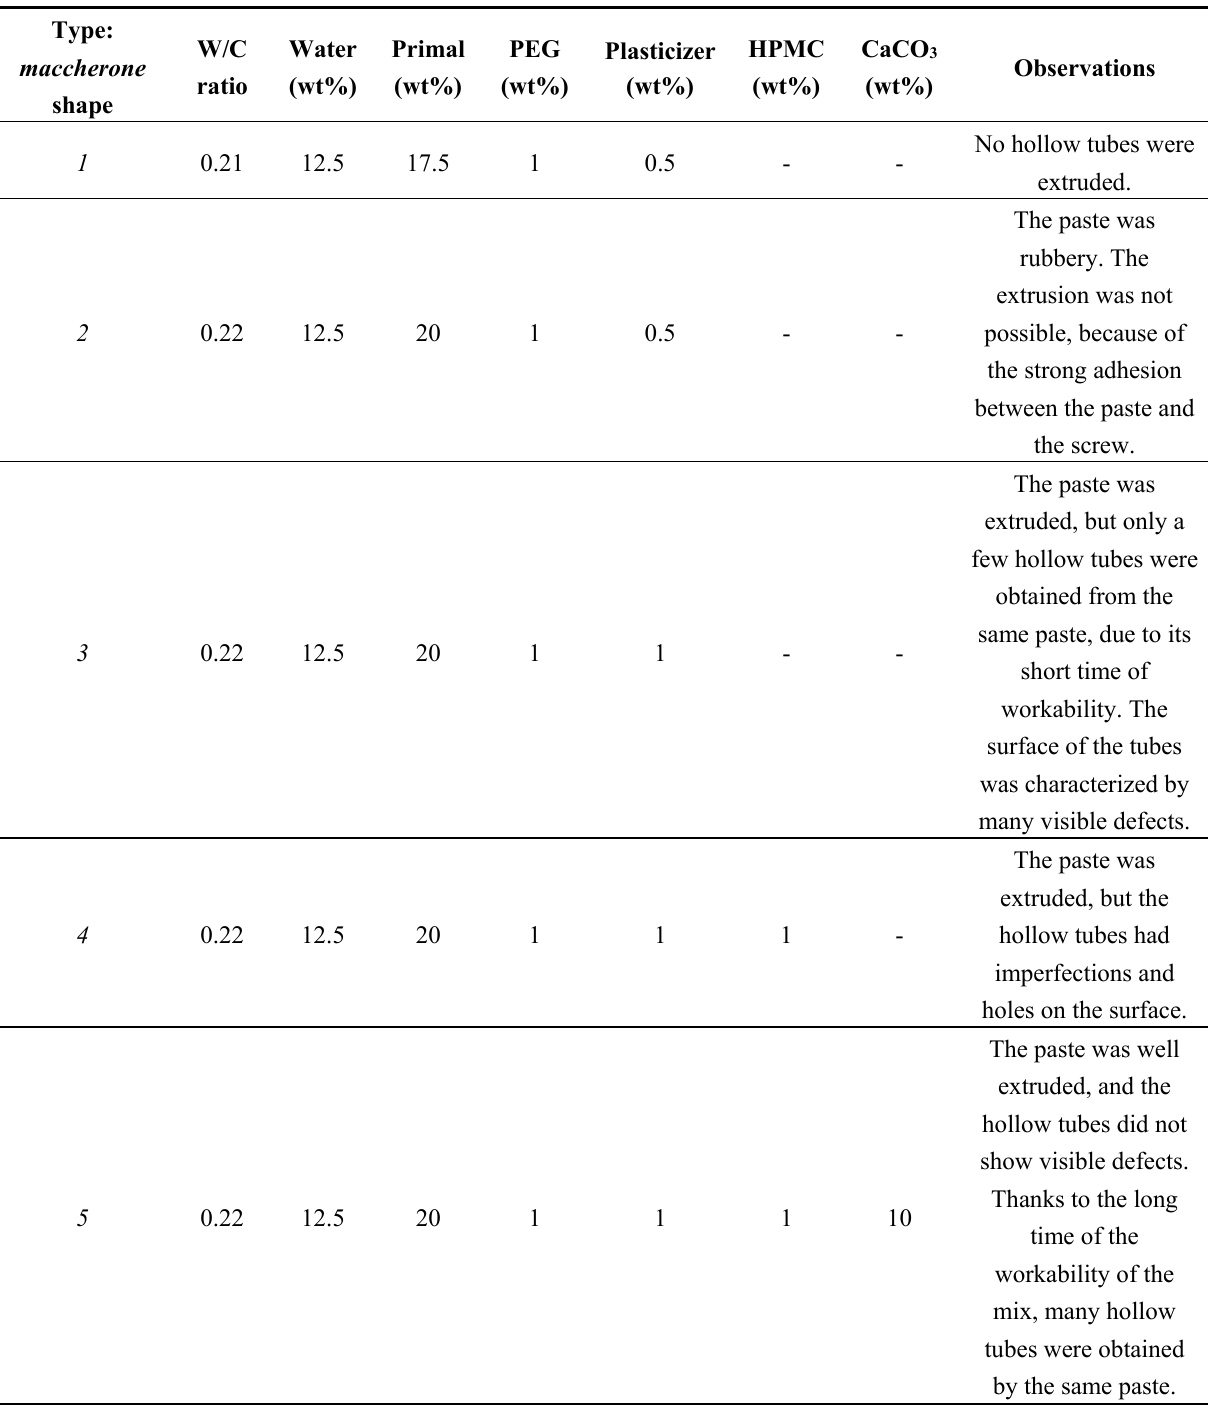
Table 2. Composition details for the extrusion of cementitious hollow tubes with a maccheroni shape (proportions with respect to